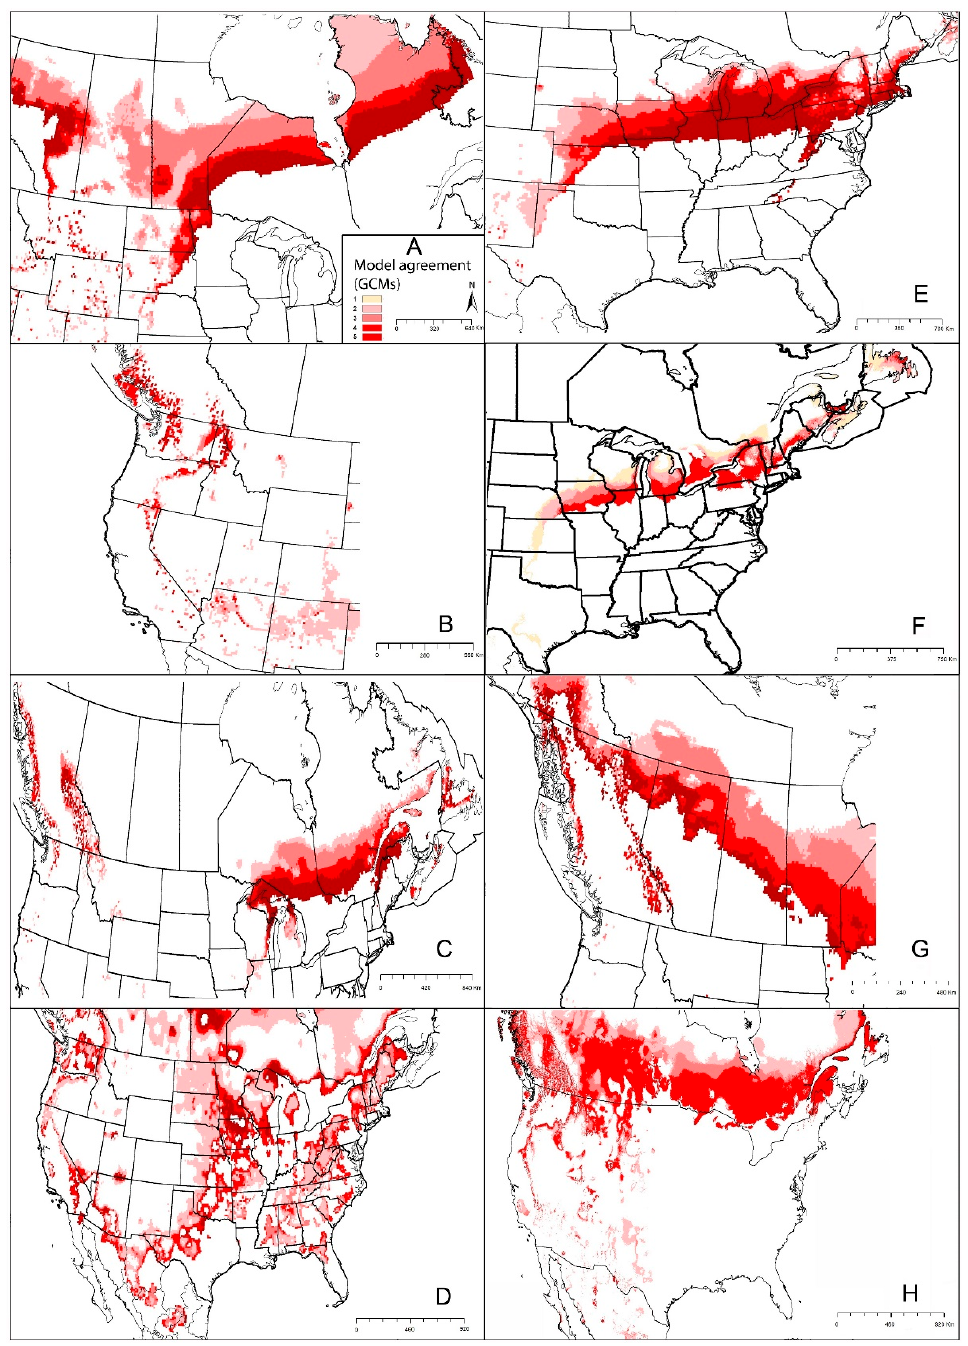
Figure 11. Summary of the potential expansion in geographic distribution of eight medical important ticks using five GCMs (CCCMA-CANESM2, CESM1-BGC, GISS-E2-R, IPSL-CM5A-MR, CCSM4) (under RCP4.5). Dark red indicates high agreement among models GCMs. ( A ) Ixodes scapularis , ( B ) I. pacificus , ( C ) I. cookei , ( D ) Rhipicephalus sanguineus , ( E ) Amblyomma maculatum , ( F ) A. americanum , ( G ) Dermacentor andersoni , ( H ) D. variabilis .